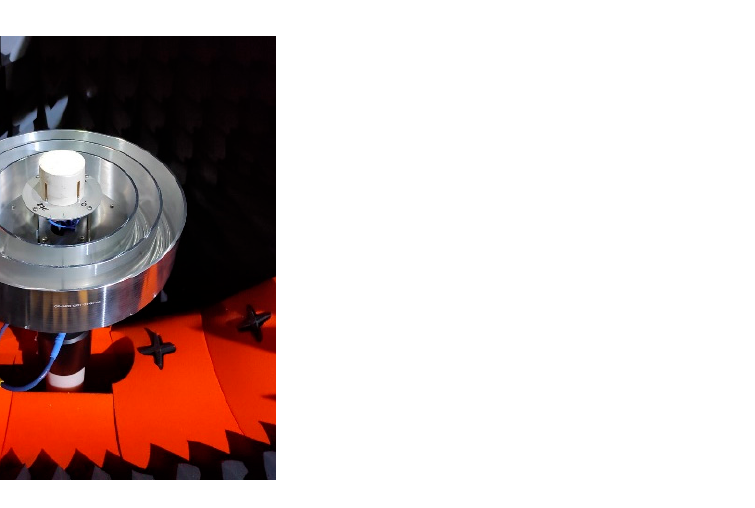
Figure 5. Novatel 703-GGG, Navxperience Nav3G+C, and Tallysman Verostar VSE6028, all in the anechoic chamber at DLR.